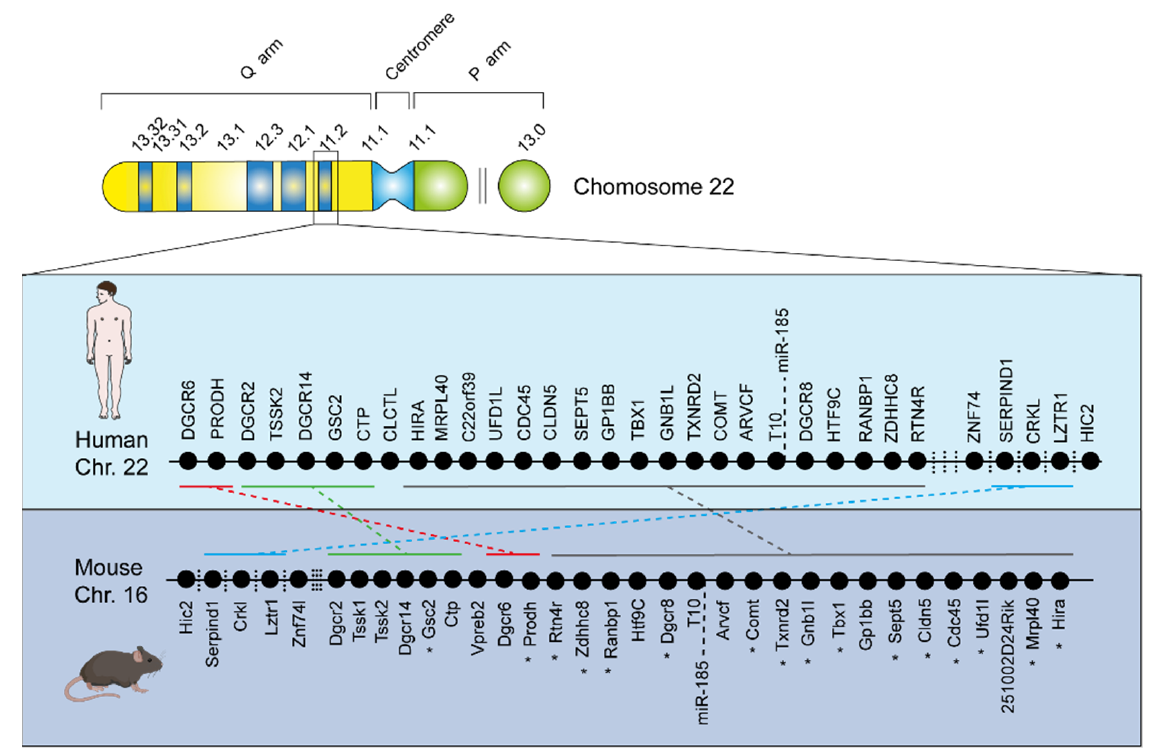
Figure 2. Genetic background of 22q11 DS. The ideogram of chromosome 22 is shown: there is a short (p) arm and long (q) arm, along with the centromere. The 22q11.2 deletion occurs in the q arm, as indicated by the box in the 22q11.2 band. The black dots represent the genes within the commonly deleted region of Chr. 22 in Humans (light blue box) and of the corresponding Chr. 16 in Mice (blue box). Dashed lines connecting groups of identical genes depict the important analogy between these genomic regions in Humans and in Mouse Models. Asterisks indicate mitochondrial genes. This characteristic allows the use of animal models to study molecular mechanisms that cannot be easily inferred working solely with human